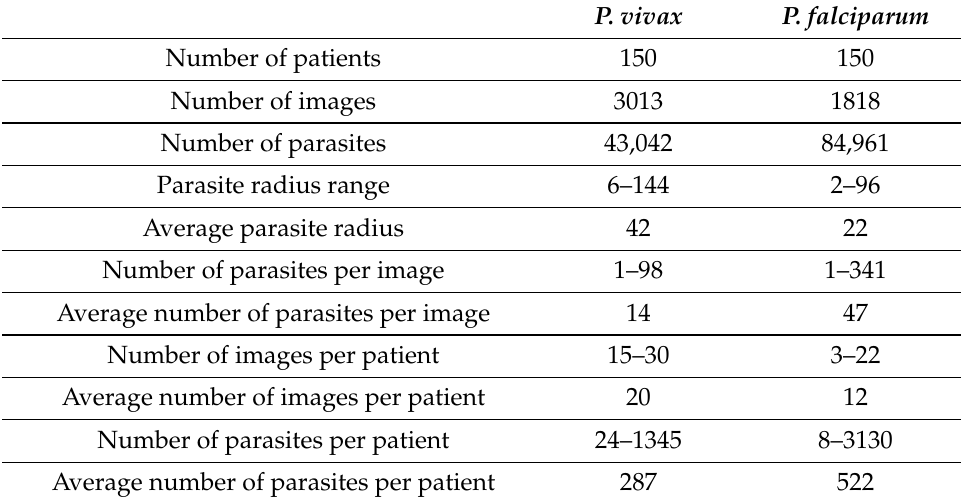
Table 1. Comparison of two infected datasets: P. falciparum and P. vivax .